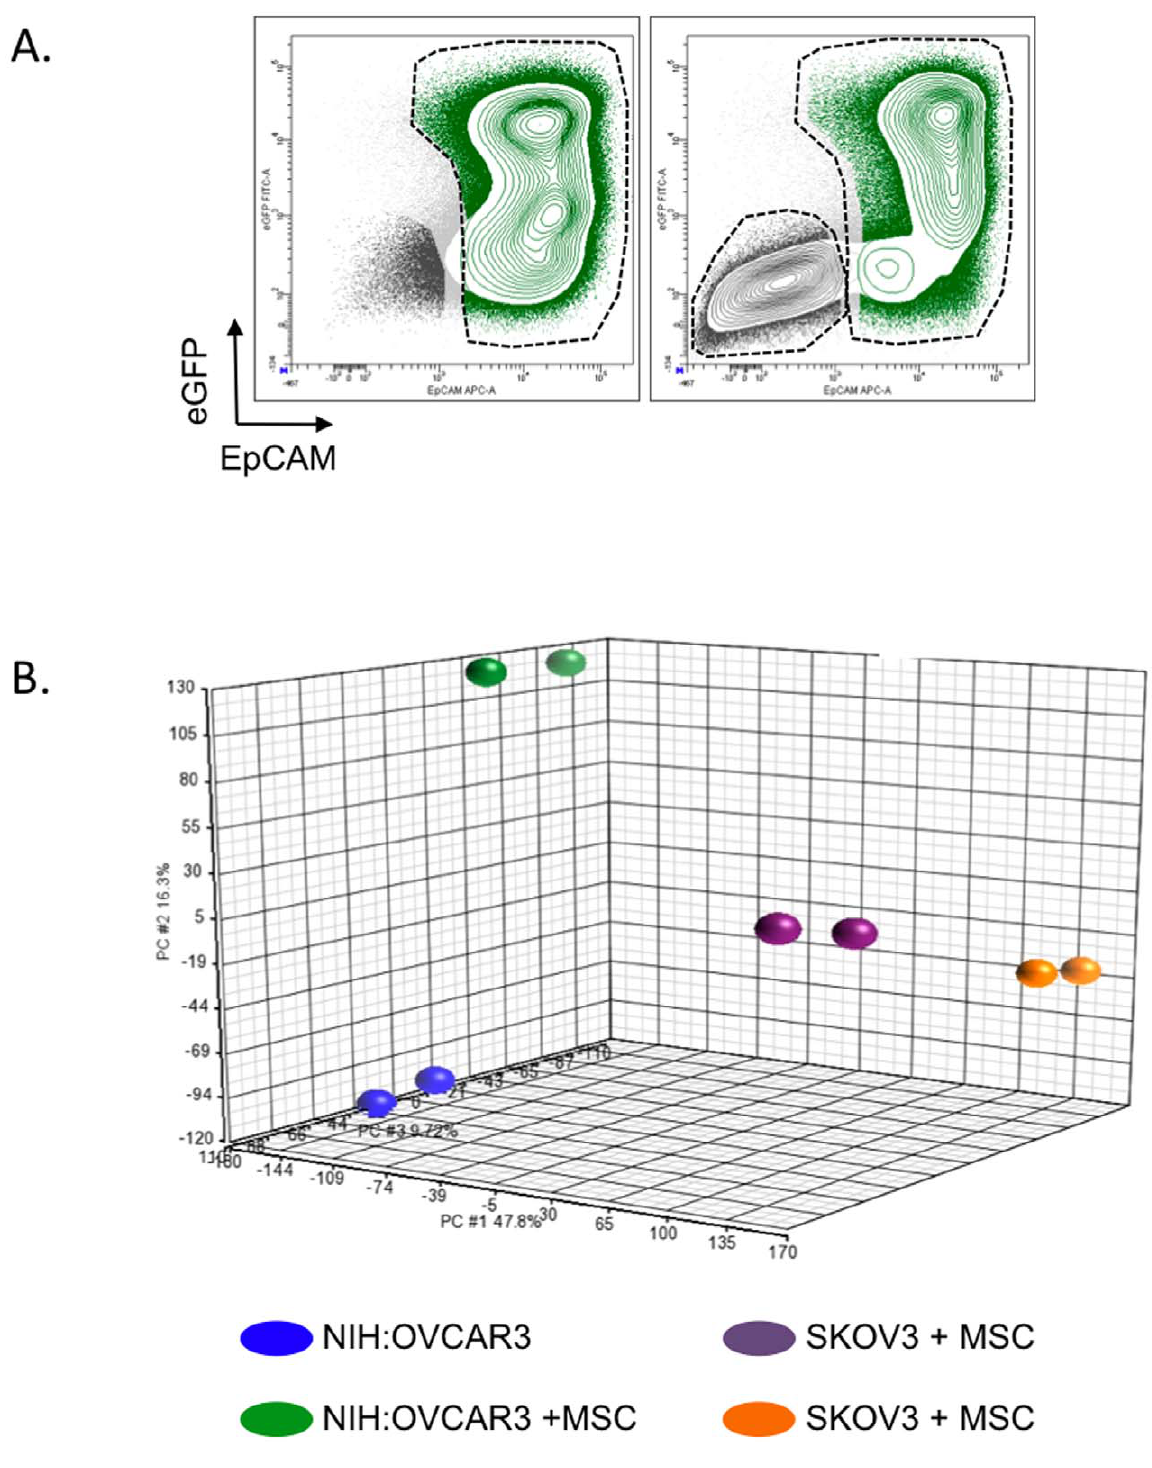
Figure 1. Modification of OCC transcriptome upon interaction with MC. A. Contour plot showing a typical discrimination of OCC and MC by FACS. OCC were defined as eGFP + EpCAM + (green population) whereas MCs were defined as eGFP-EpCAM- (dark grey population). B. PCA analysis for the ovarian cancer cells lines alone or post-contact with the Mesenchymal cells. doi:10.1371/journal.pone.0038340.g001 p = 4.36.48*10 2 7 ; SKOV3, p= 6.79*10 2 6 ) and ‘‘Cell death of Taken together these data indicate that despite the lack of tumor cell line’’ (NIH:OVCAR3, p =5.68*10 2 8 ; SKOV3, overlapping regarding the genes up-or down-regulated by MC p = 7.62*10 2 5 ). These clusters were shared between NIH:OV- contact, the same biological function clusters were enriched in the CAR3-eGFP and SKOV3-eGFP (Table 1). two ovarian cancer cell line we tested. In this article, we set forth